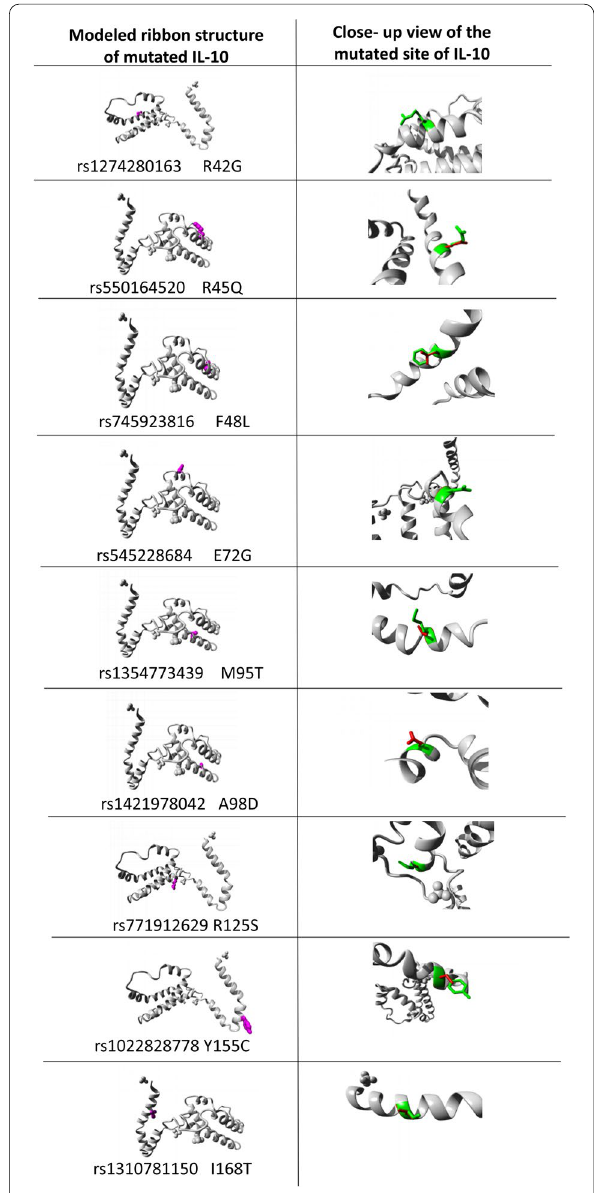
Fig. 4 Prediction of 3-D model structure of IL-10 protein by using Project HOPE. Here, violet color on the ribbon diagram represents the site of mutation. Green and red colors indicate native and mutated amino acids,